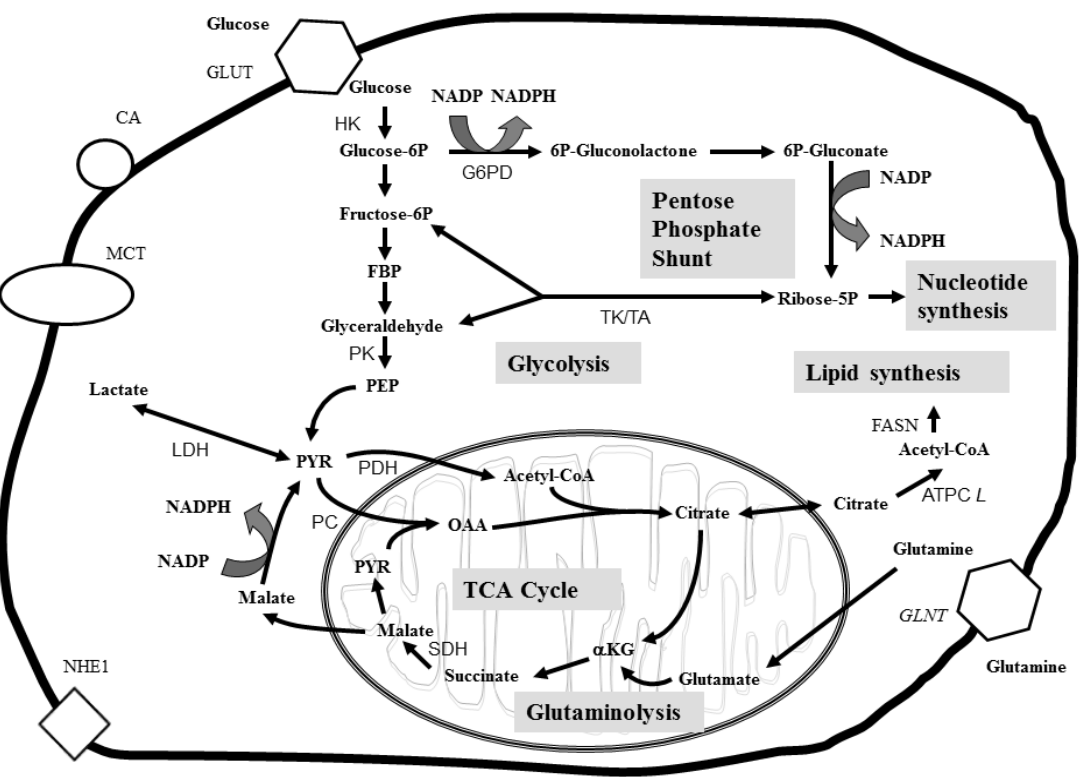
Figure 2. Energy and metabolic pathways and associated protein enzymes and transporters active in cancer. Metabolite abbreviations:  KG,  -ketoglutarate; FBP, fructose 1,6-diphosphate; NADP, nicotinamide adenine dinucleotide phosphate; NADPH, reduced form of nicotinamide adenine dinucleotide phosphate; OAA, oxaloacetate; PEP, phosphoenol pyruvate; PYR, pyruvate. Protein abbreviations: ATPCL, ATP citrate lyase; CA, carbonic anhydrase; FASN, fatty acid synthase; GLUT, glucose transporter; GLNT, glutamine transporter; G6PD, glucose-6-phosphate dehydrogenase; HK, hexokinase; LDH, lactate dehydrogenase; MCT, monocarboxylate transporter; NHE1, Na + /H + exchanger; PC, pyruvate carboxylase; PDH, pyruvate dehydrogenase; PK, pyruvate kinase; SDH, succinate dehydrogenase; TK/TA,